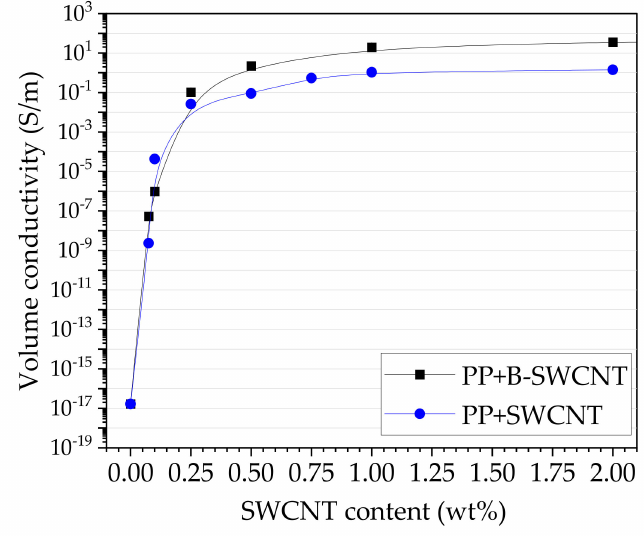
Figure 5. Electrical volume conductivity of PP composites depending on SWCNT